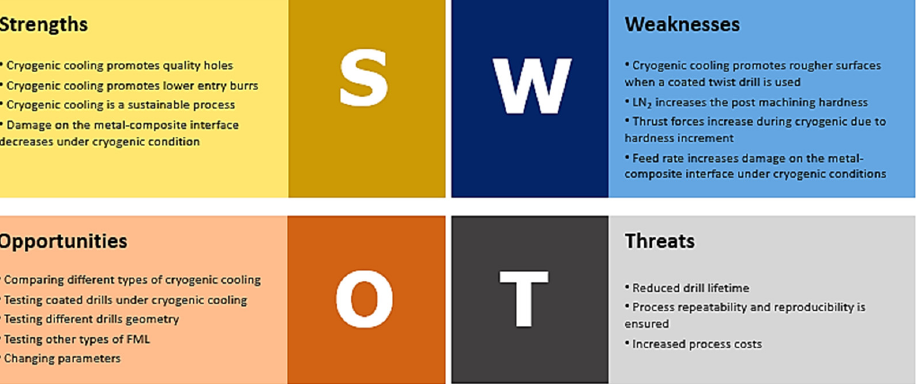
Figure 18. SWOT analysis of lubricants and coolants obtained by comparing between MQL, dry and cryogenic cooling.